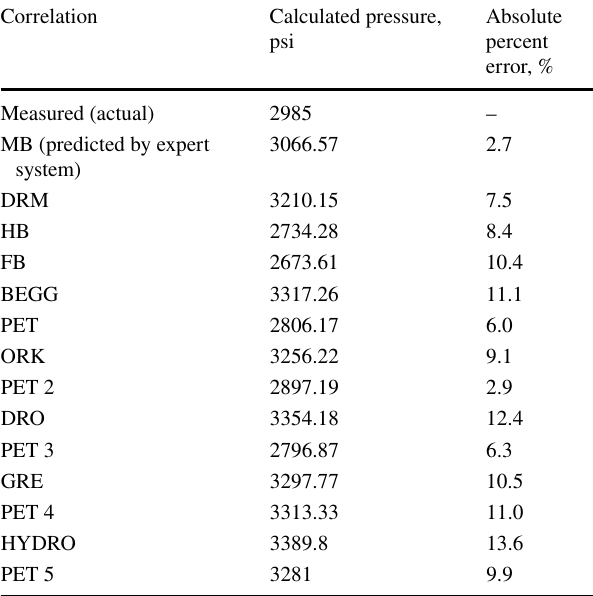
Table 22 Calculated pressure and absolute percent error from differ- ent correlations compared to actual data